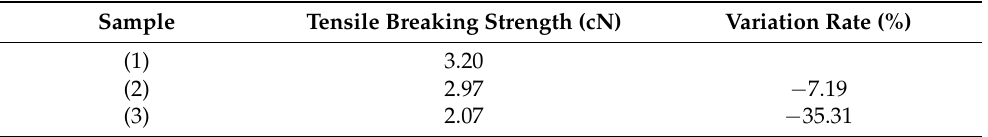
Table 1. Tensile breaking strength of diacetate fiber samples.